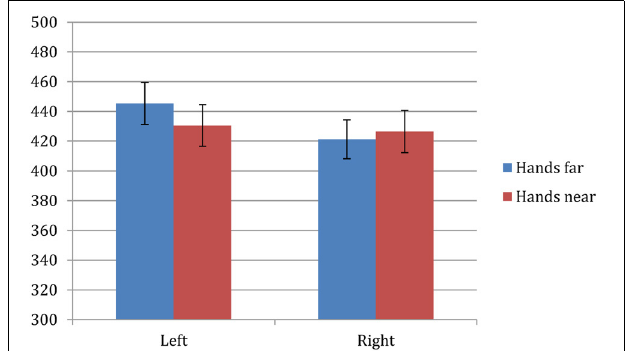
FIGURE 2 | Experiment 1 results. ANOVA revealed a significant interaction between hand proximity and laterality ( F = 8 . 728, p = 0 . 008), which was driven by a significant difference between the left and right hand in the hands-far condition (right: 421ms, left: 445ms, p = 0 . 002) that became nonsignificant in the hands-near condition (right: 426ms, left: 430ms, p = 0 . 46). Therefore, left-hand RT was speeded up to be on par with the right hand when one’s own hands were near the audio